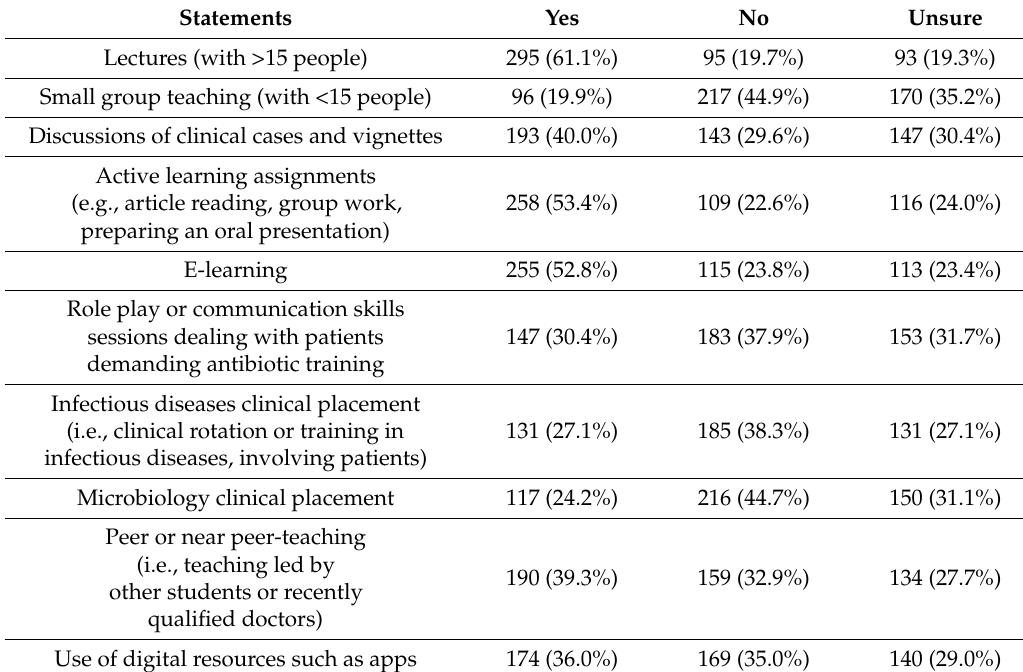
Table 3. Teaching methods used to teach students about prudent use of antibiotics/antibiotic